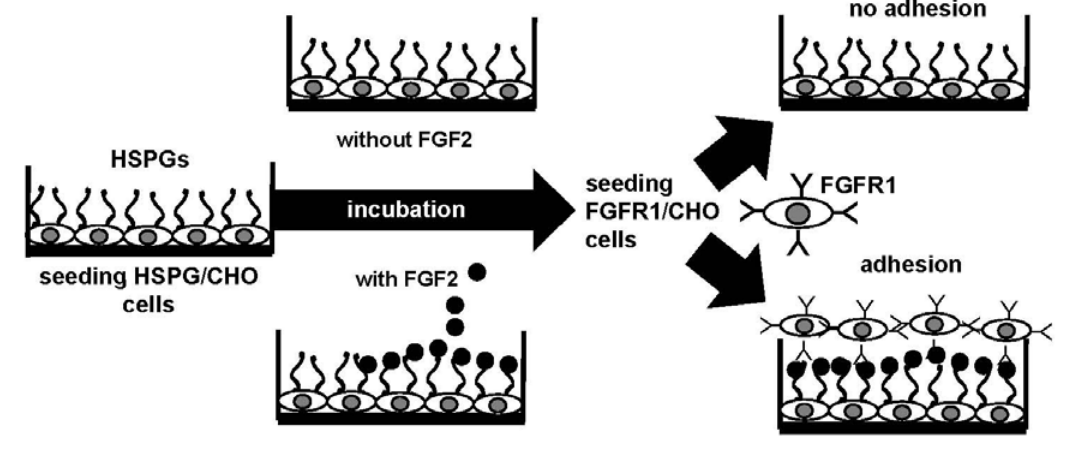
Figure 4. Schematic representation of the FGF2-mediated cell-cell adhesion model. HSPG-bearing CHO (HSPG/CHO) cells are seeded, allowed to reach confluence and incubated with or without FGF2. Next, FGFR1-bearing CHO (FGFR1/CHO) cells are incubated onto the HSPG/CHO cell monolayers. Finally, FGFR1/CHO cells adherent to the HSPG/CHO cell monolayers are counted under the